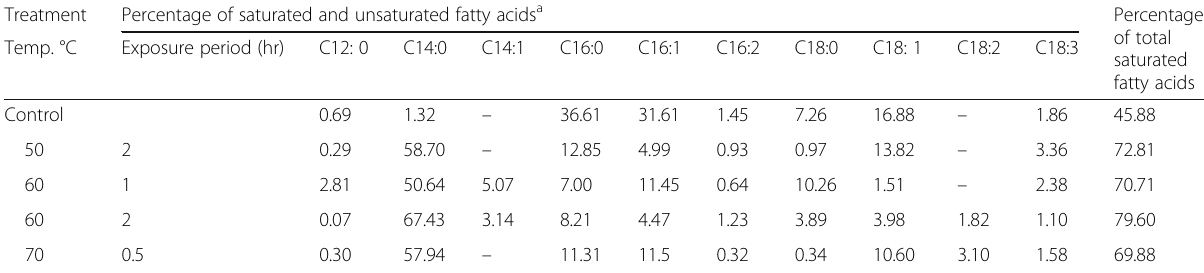
Table 7 Effect of seed hardening on the percentage of fatty acids in plant shoots Treatment Percentage of saturated and unsaturated fatty acids a Percentage